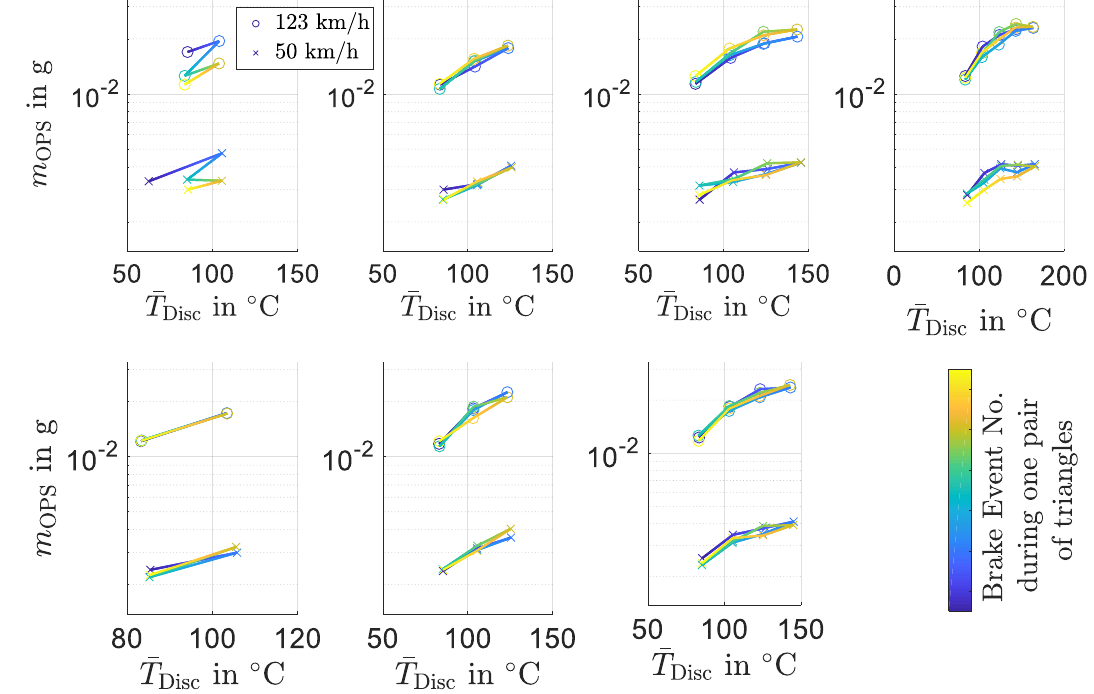
Figure 10. PM 10 emissions per brake event averaged for each temperature step of the pad material with an organic binder and the operating point pair 1&4 (50 and 123 km/h).